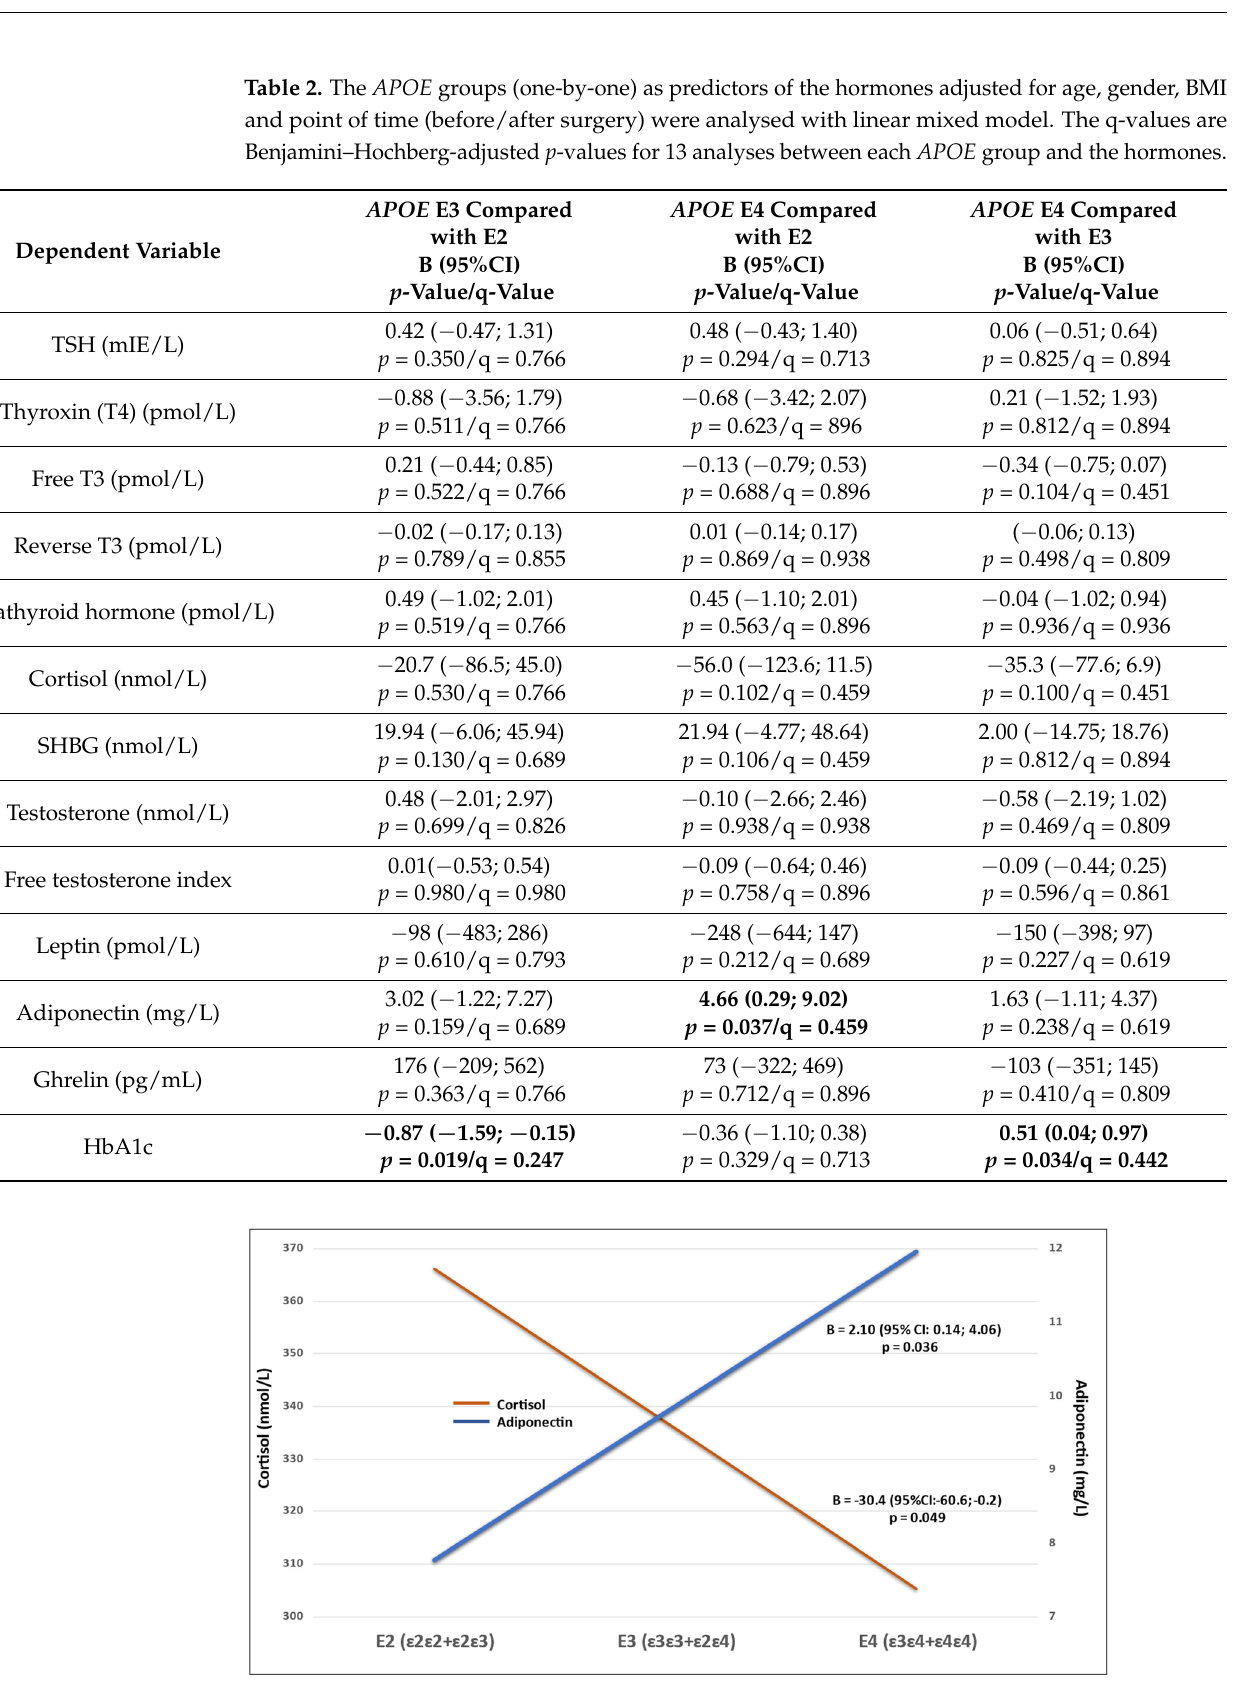
Table 2. The APOE groups (one-by-one) as predictors of the hormones adjusted for age, gender, BMI and point of time (before/after surgery) were analysed with linear mixed model. The q-values are Benjamini–Hochberg-adjusted p -values for 13 analyses between each APOE group and the hormones.